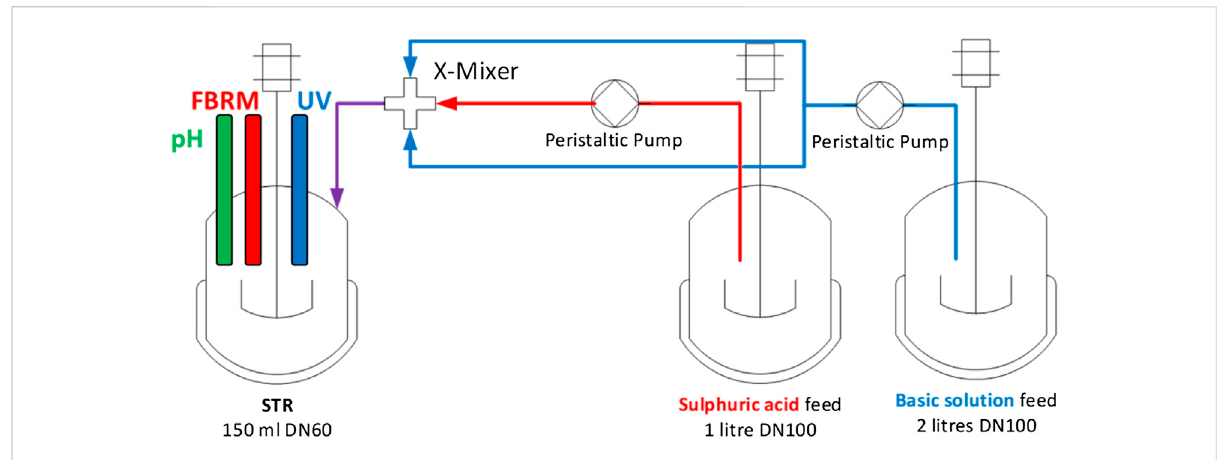
FIGURE 7 Semi-batch process with dimensions